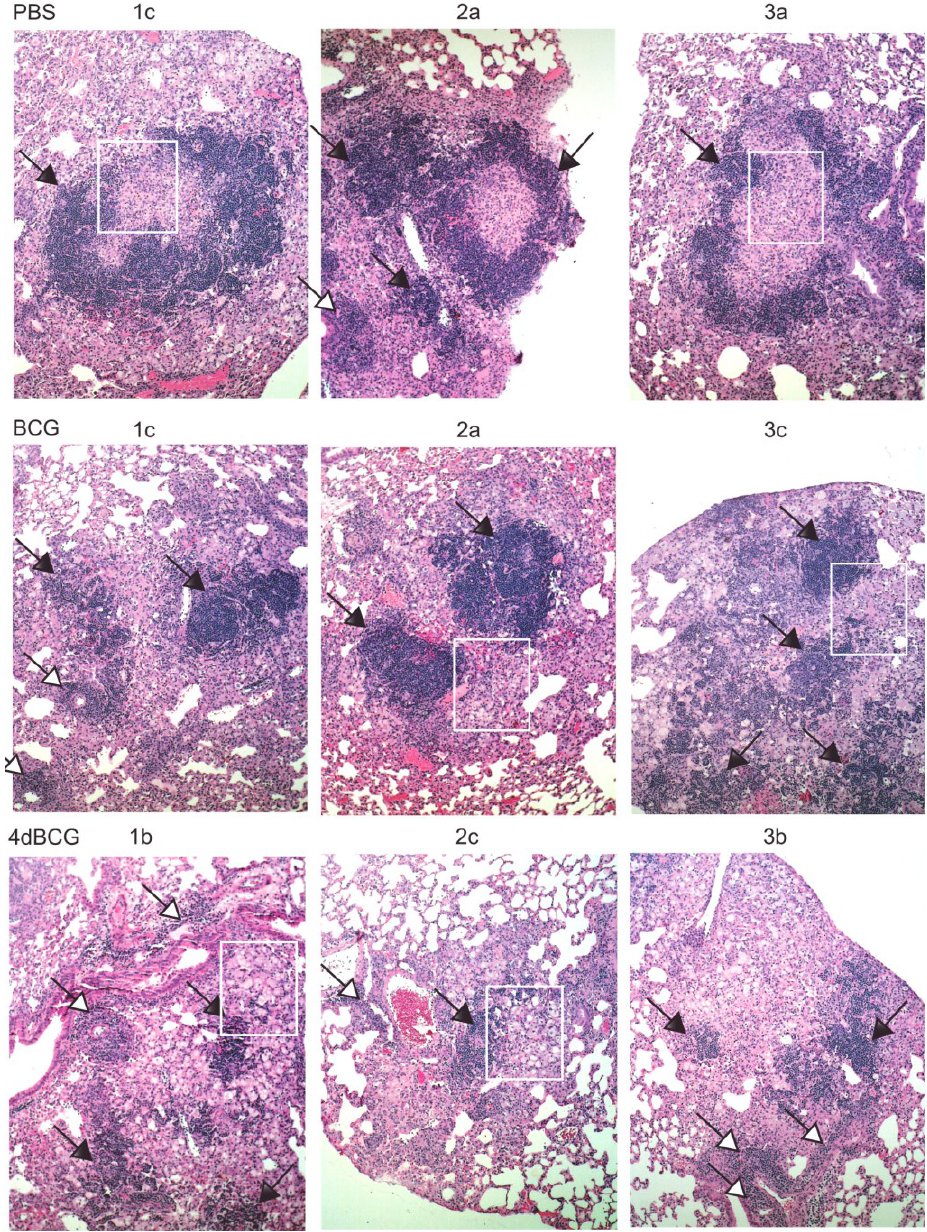
Figure 5. Lymphohistiocytic nodules in the lung parenchyma. Mid-power (×10 microscope objective) photomicrographs of regions of lung consolidation within the tissue sections in Figure 4 are displayed at a greater magnification. Most of the areas that stain dark blue in the PBS and BCG groups represent dense collections of lymphocytes within the lung parenchyma that are accompanied by lymphohistiocytic infiltration and consolidation of the alveolar spaces. Examples of these regions are indicated with arrows (black arrowheads) and the white rectangles outline regions of lung tissue that are enlarged further in Figure 6. Lymphoid aggregates were also observed in the lung parenchyma in the 4dBCG group of mice however they were typically smaller with less dense alveolar infiltrate compared to the PBS and BCG groups. The arrows with white arrowheads indicate BALT, which is distinguished from lymphohistiocytic nodules in the lung parenchyma by their association with blood vessels and